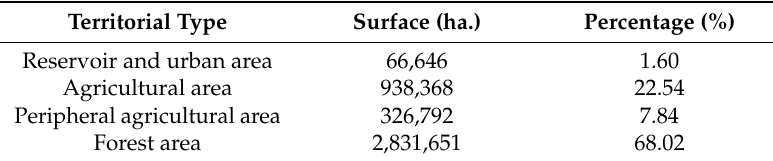
Table 1. Territorial distribution of Extremadura province (Spain) [35,36].